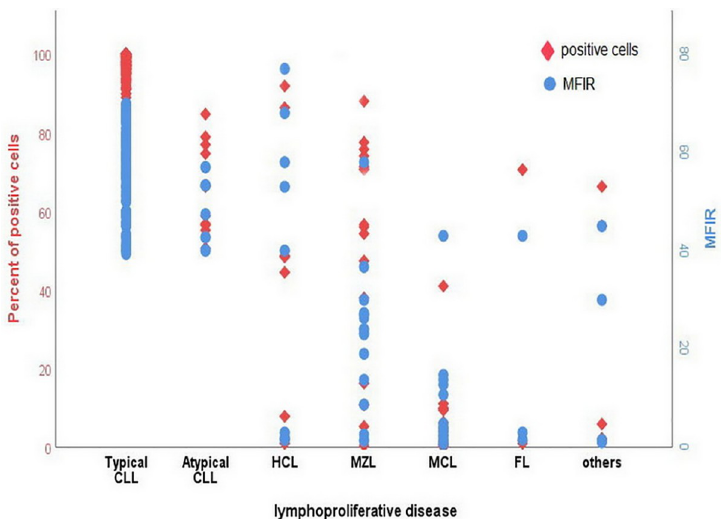
Fig 1. CD200 expression levels (percent of positive cells and MFIR) on 252 B- chronic lymphoproliferative disorders enrolled in this study.